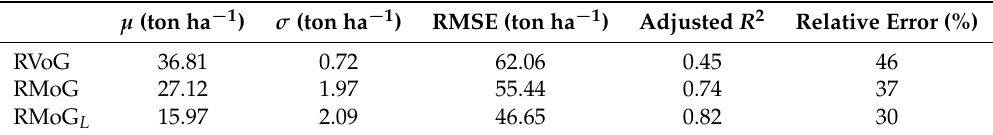
Table 6. Result of evaluating fitted exponential model using test